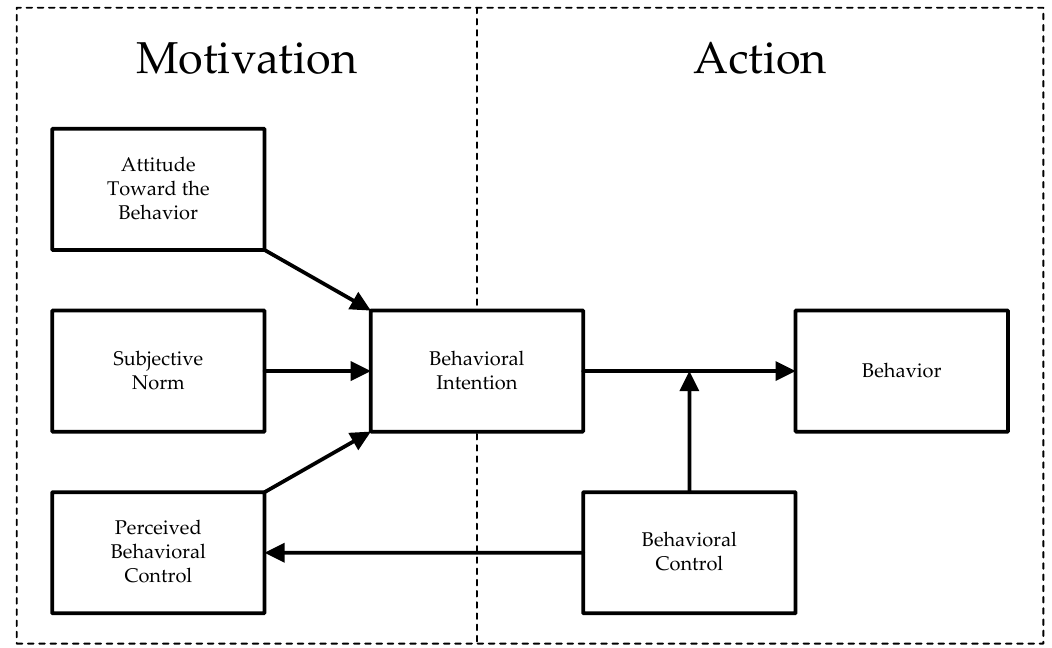
Figure 1. Theory of planned behavior. Motivational components affect behavioral intention. Behavioral control moderates the linkage between intention and behavior.